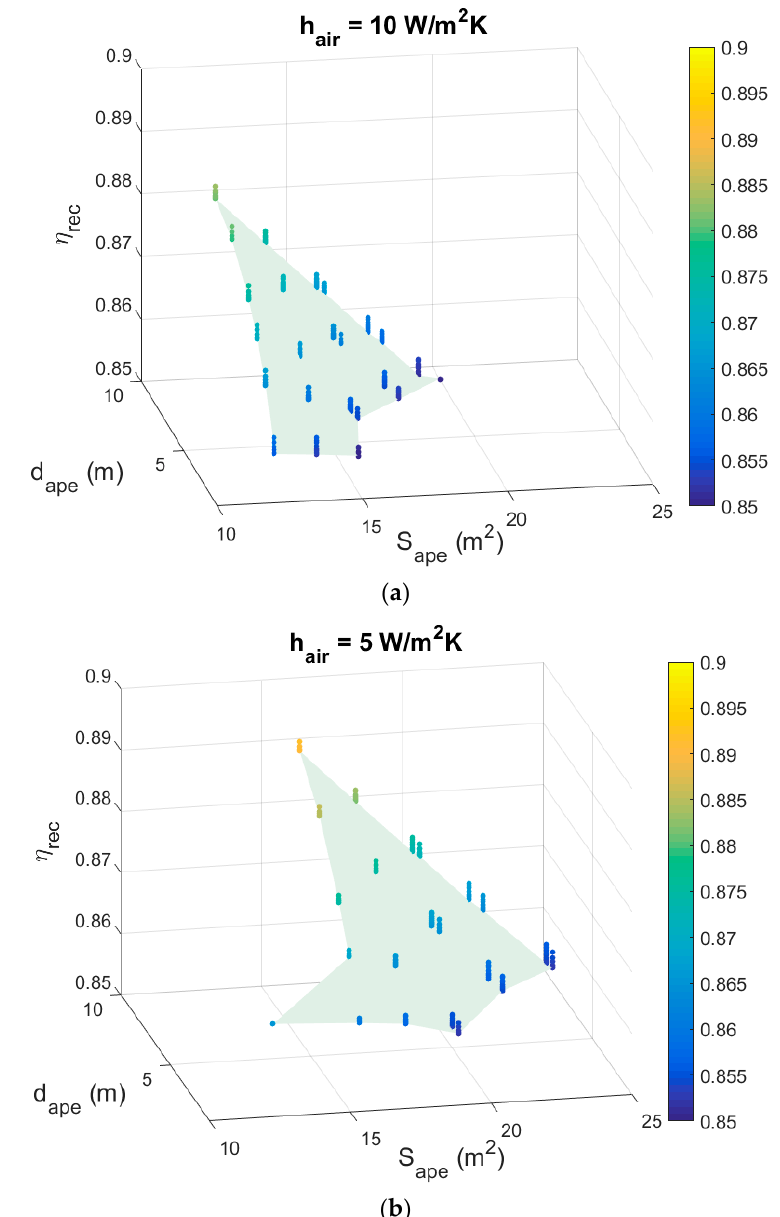
Figure 10. Maps of the domain of parameters that allows to reach the targeted receiver efficiency, with a convection coefficient h air of 10 W/m 2 K ( a ) and 5 W/m 2 K ( b ), for the following parameters: M = 5 panels and α = 30°.